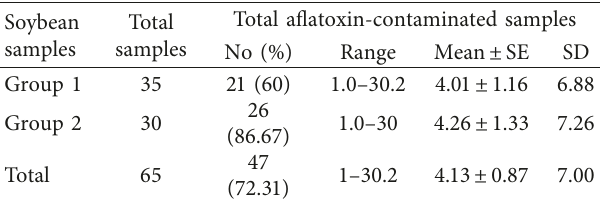
Figure 1: Linear regression curve and equation for the aflatoxin standard in ELISA (given in μ g/kg). Table 2: Total aflatoxins in soybean samples.